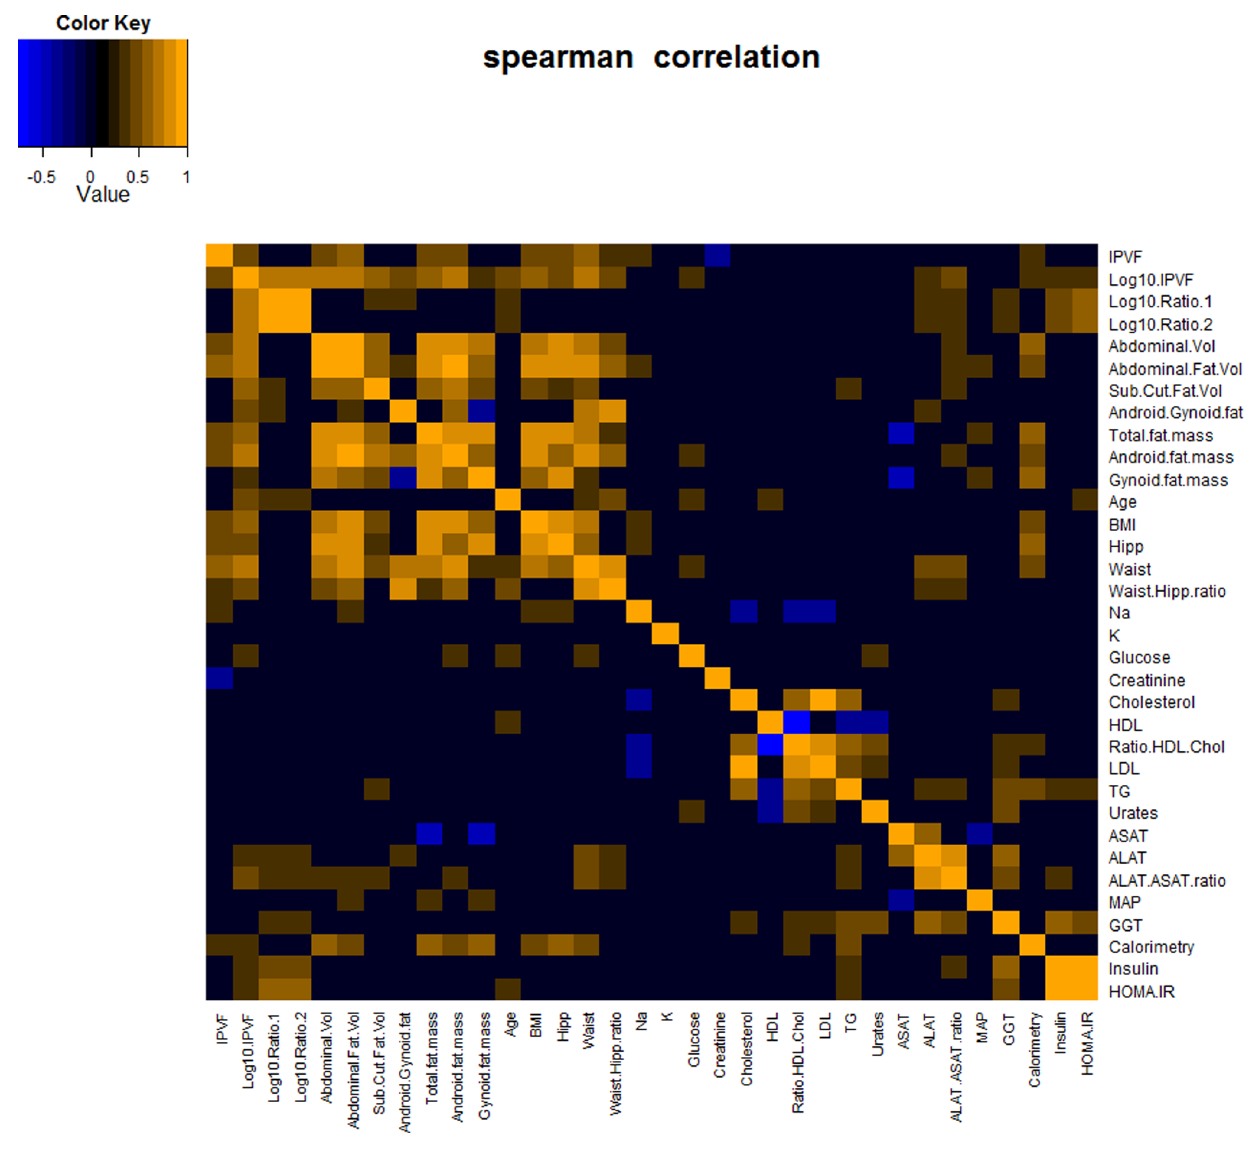
Figure 2. Statistically significant Spearman correlation map between body fat composition parameters and clinical measures (95% confidence interval). Log 10 values of IPVF, VAT/SAT, VAT/total abdominal fat were strongly associated with HOMA-IR (r=0.39, p=0.015; r=0.56, p , 0.001; r=0.55, p , 0.001) and fasting insulin (r=0.35, p=0.0275; r=0.49, p=0.0017; r=0.48, p=0.0020). Strong associations were observed with ALAT (r=0.39, p=0.0128; r=0.37, p=0.0175; r=0.38, p=0.0167) and ALAT/ASAT ratio (r=0.44, p=0.0044; r=0.35, p=0.0268; r=0.35, p=0.0302). IPVF and Log 10 values of IPVF correlated with waist (r=0.55, p , 0.001; r=0.35, p=0.04) and waist/hip ratio (r=0.69, p , 0.001; r=0.52, p=0.0017), but not Log 10 values of VAT/SAT and VAT/total abdominal fat. NB: Blue denotes negative correlation, orange denotes positive correlation, and black denotes no correlation.